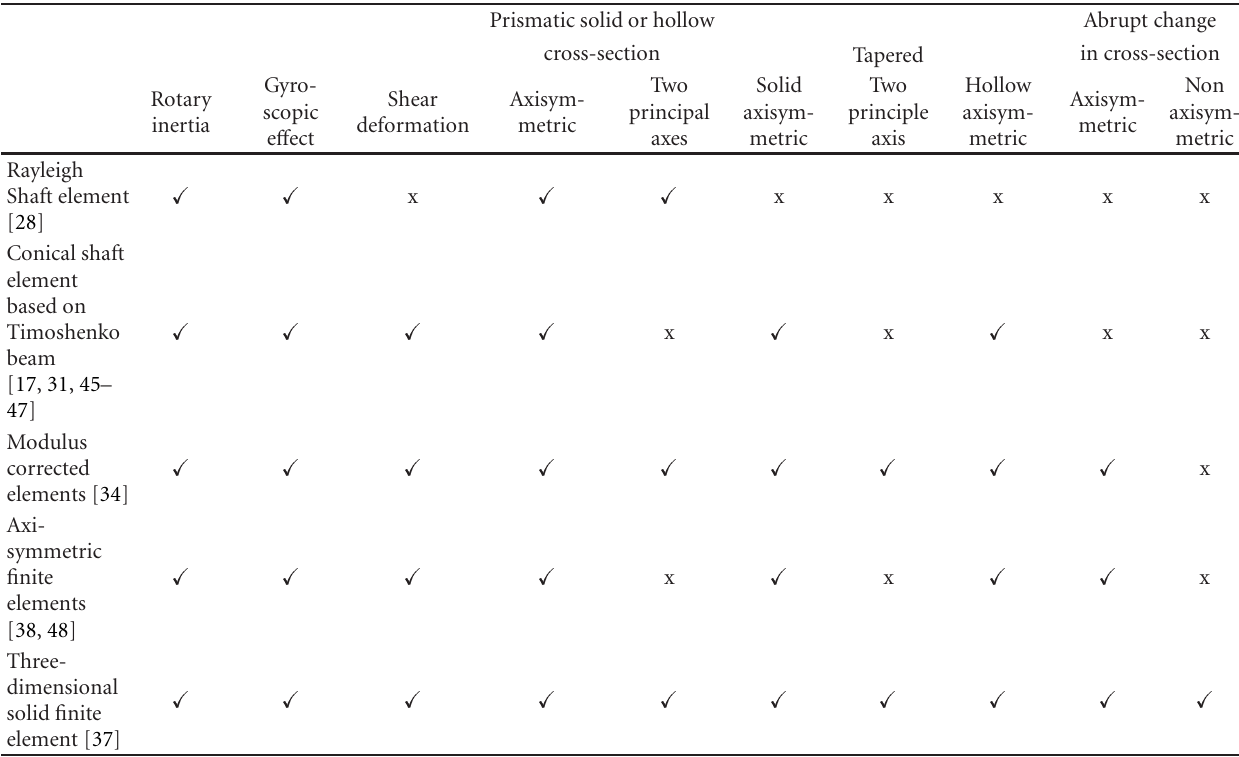
Table 3: A brief review of the capabilities of finite element methods proposed to model a rotating shaft-disk system [35]. Prismatic solid or hollow Abrupt change cross-section Tapered in cross-section